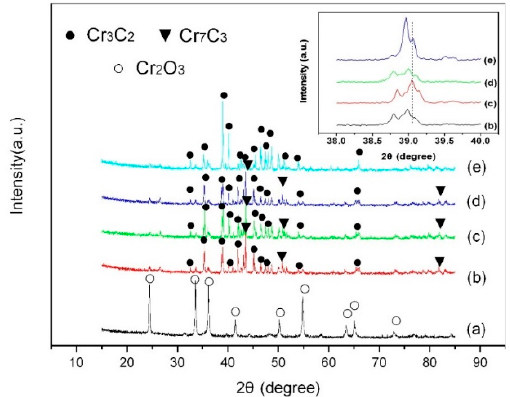
Figure 2. XRD patterns of the powders before and after microwave heating: ( a ) before microwave heating; ( b ) 0.5 h; ( c ) 1 h; ( d ) 1.5 h; ( e ) 2 h. The insertion is an enlargement of the diffraction peaks of